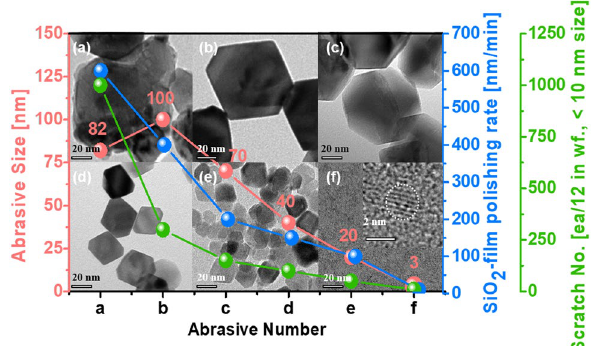
Figure 1. Dependencies of the SiO 2 film polishing rate and allowable scratch number on the size of dry or wet CeO 2 abrasives. ( a ) 82 nm dry CeO 2 abrasives, ( b ) 100 nm, ( c ) 70 nm, ( d ) 40 nm, ( e ) 20 nm, and ( f ) 3 nm wet CeO 2 abrasives. Dry CeO 2 abrasives with an irregular surface are produced via a milling process of cerium carbonate, whereas wet ceria abrasives containing f.c.c.-crystalline facets are synthesized by a conventional wet precipitation process at 60–80 °C.